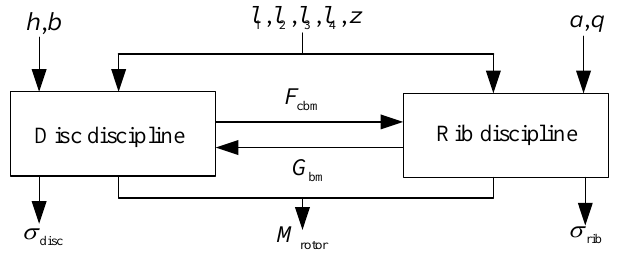
Figure 7. Force diagram of components. M rotor is used as the objective function of the rotor mechanism design optimization problem. The strength of each part of the mechanism and the reasonable range of variation in size are used as constraints.